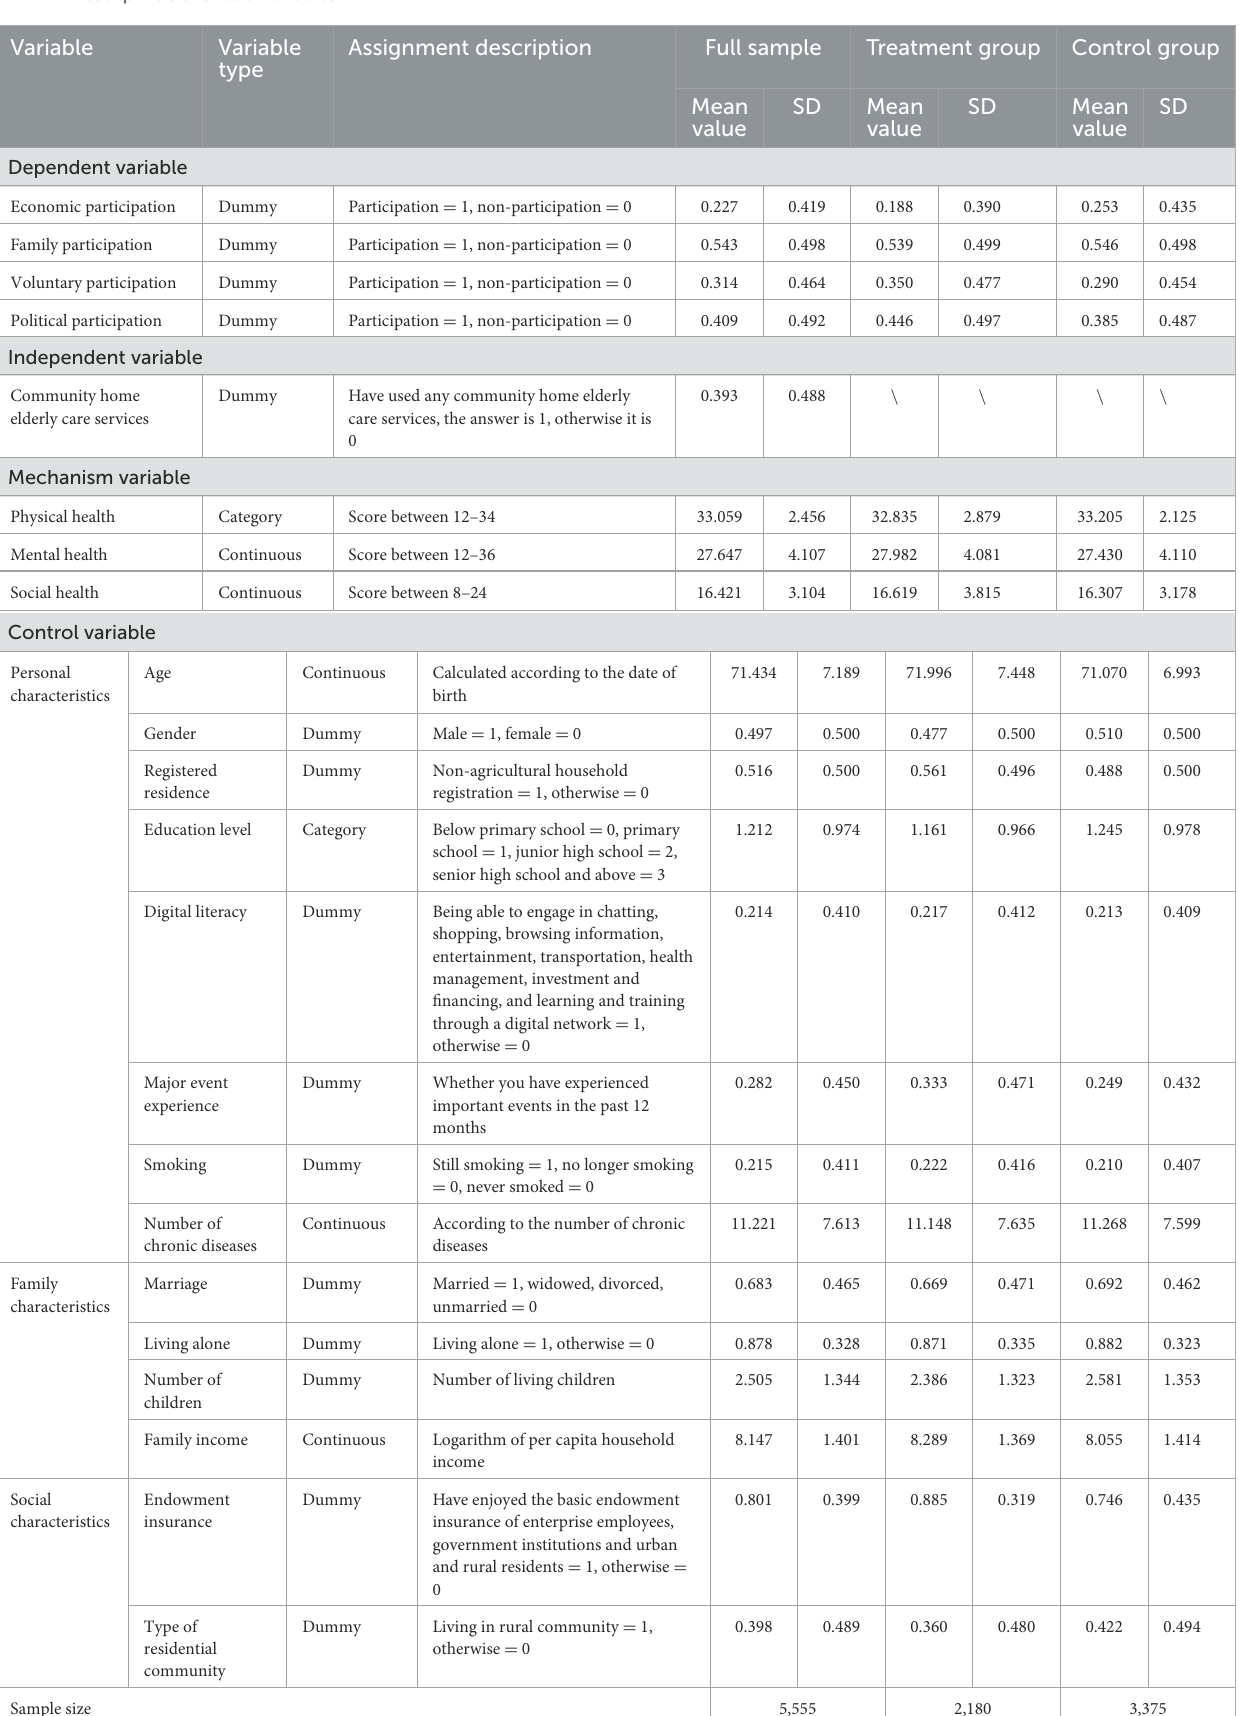
TABLE 1 Descriptive statistics of